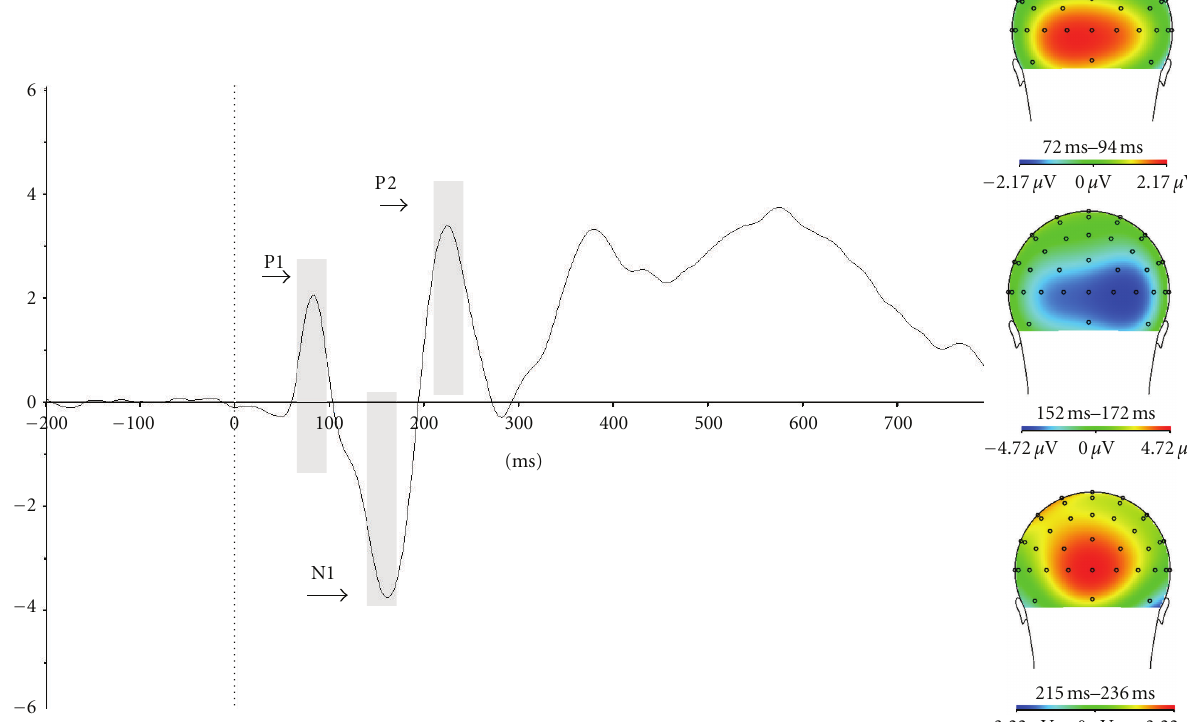
Figure 6: Visual evoked potentials (VEP) obtained by the presentation of infrequent position target. P1, N1, and P2 were maximal at Oz.